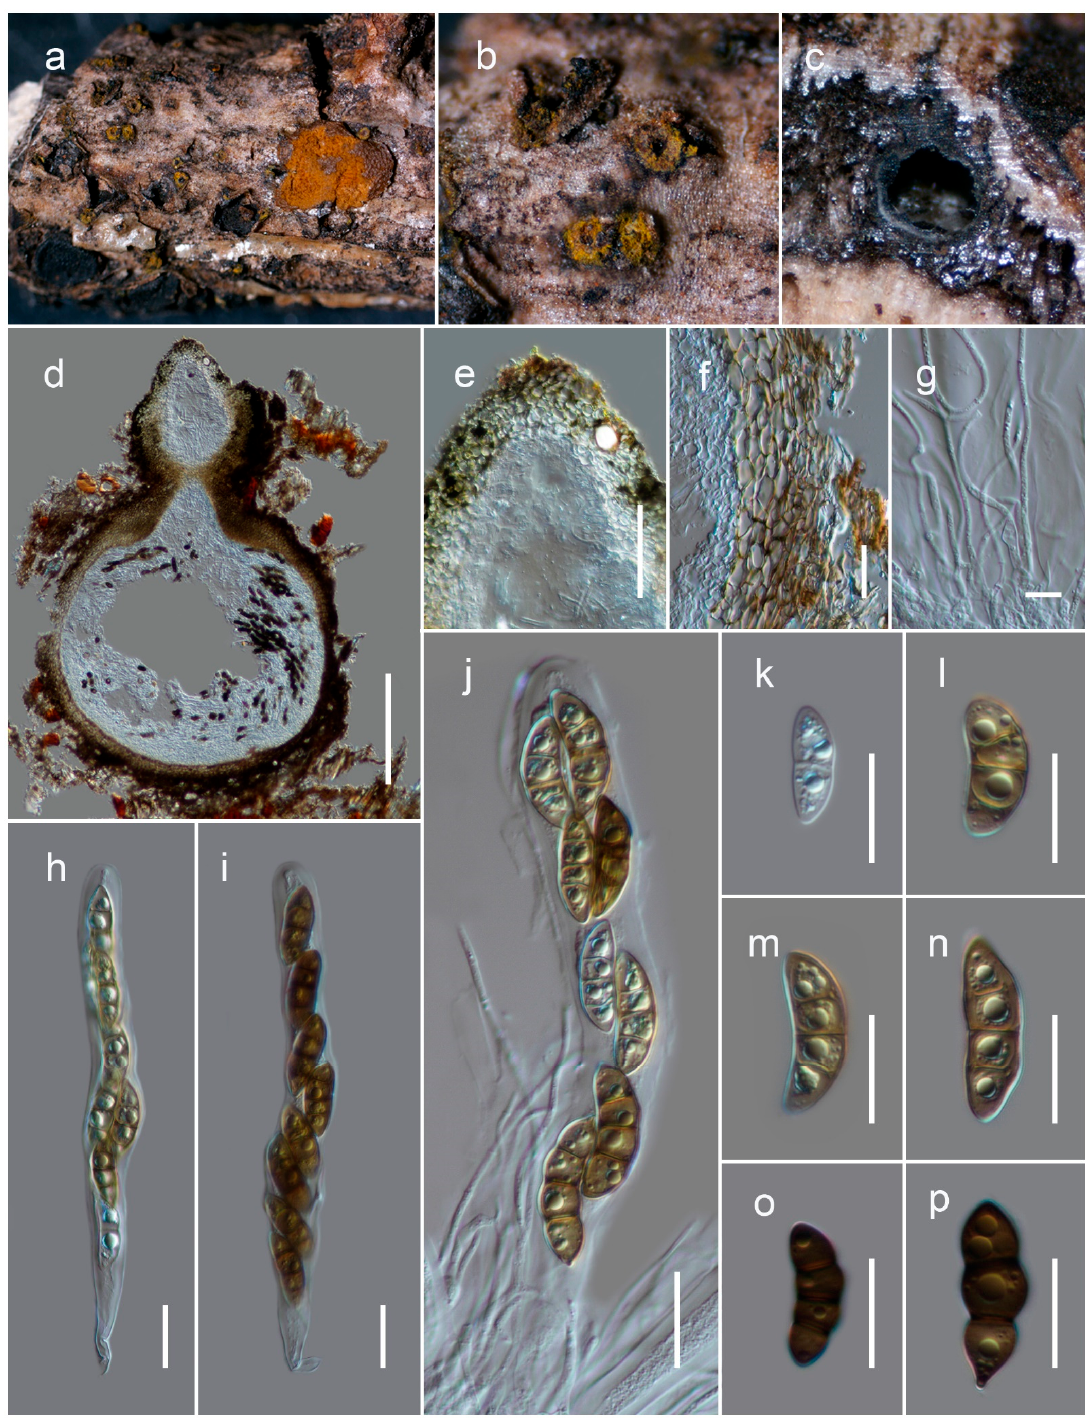
Figure 5. Sexual morph of Thyridaria jonahhulmei (HKAS122912, holotype). ( a,b ) Ascomata on the dead woody twigs; ( c,d ) cross section of ascomata; ( e ) close-up of ostiole; ( f ) peridium; ( g ) pseudopa- raphyses; ( h – j ) asci; ( k – p ) ascospores. Scale bars, ( d ) 200 µ m; ( e ) 50 µ m; ( f,h – j ) 20 µ m; ( f , k – p ) 10 µ